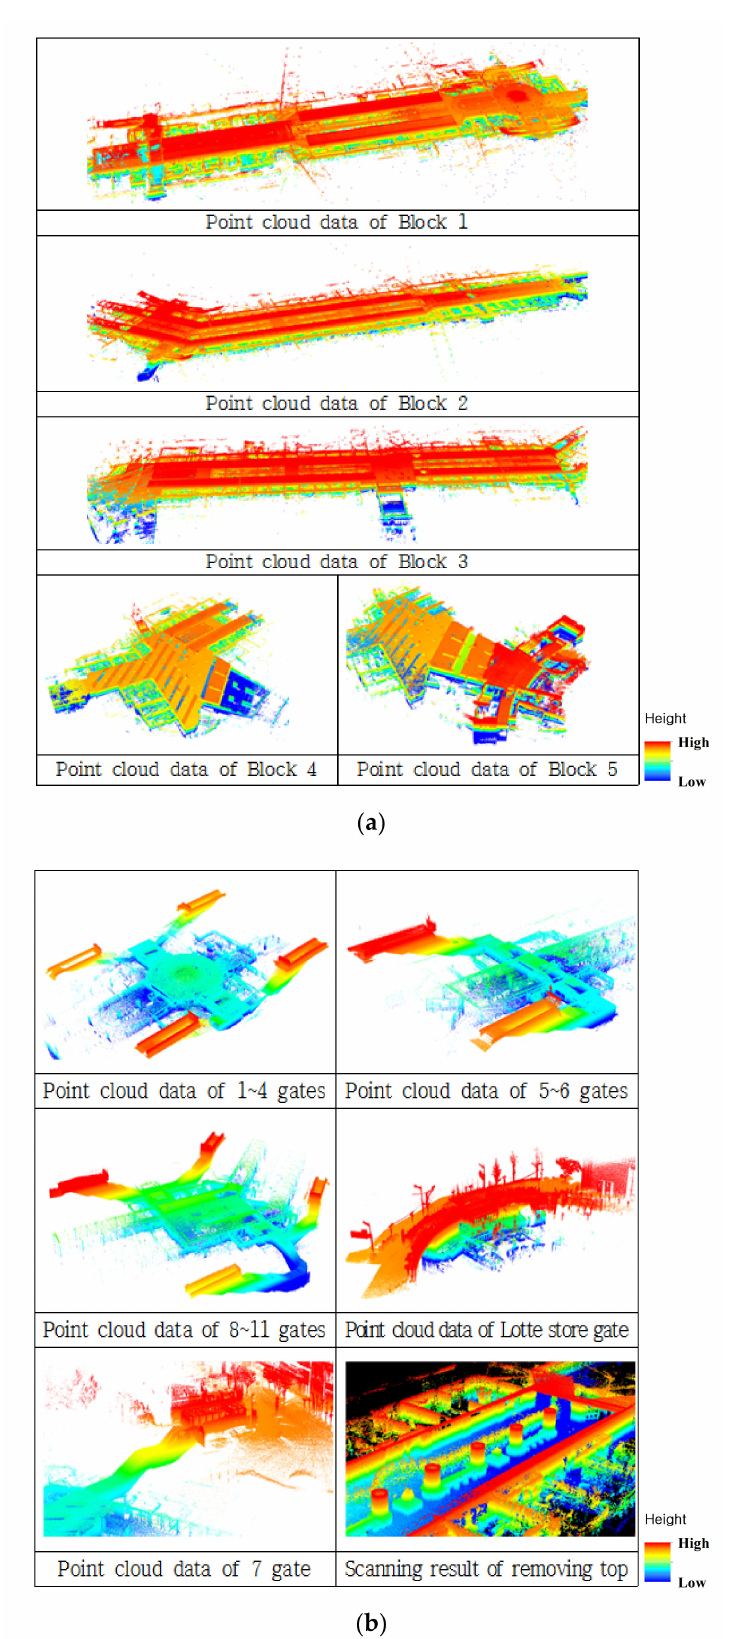
Figure 2. Building point cloud data for each block. ( a ) Point cloud data for each block (inside the shopping center). ( b ) Point cloud data for each block (gates). Color is a relative height value, higher is red and lower is